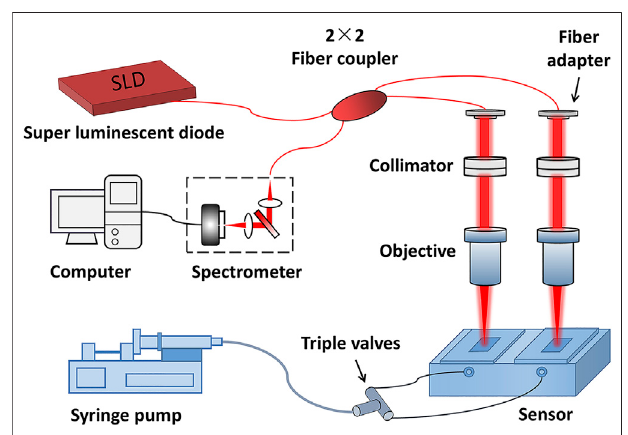
FIGURE 1 | The self-reference setup of biomolecule